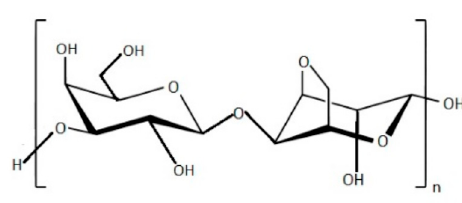
Figure 3. Chemical structure of agarose polymer.